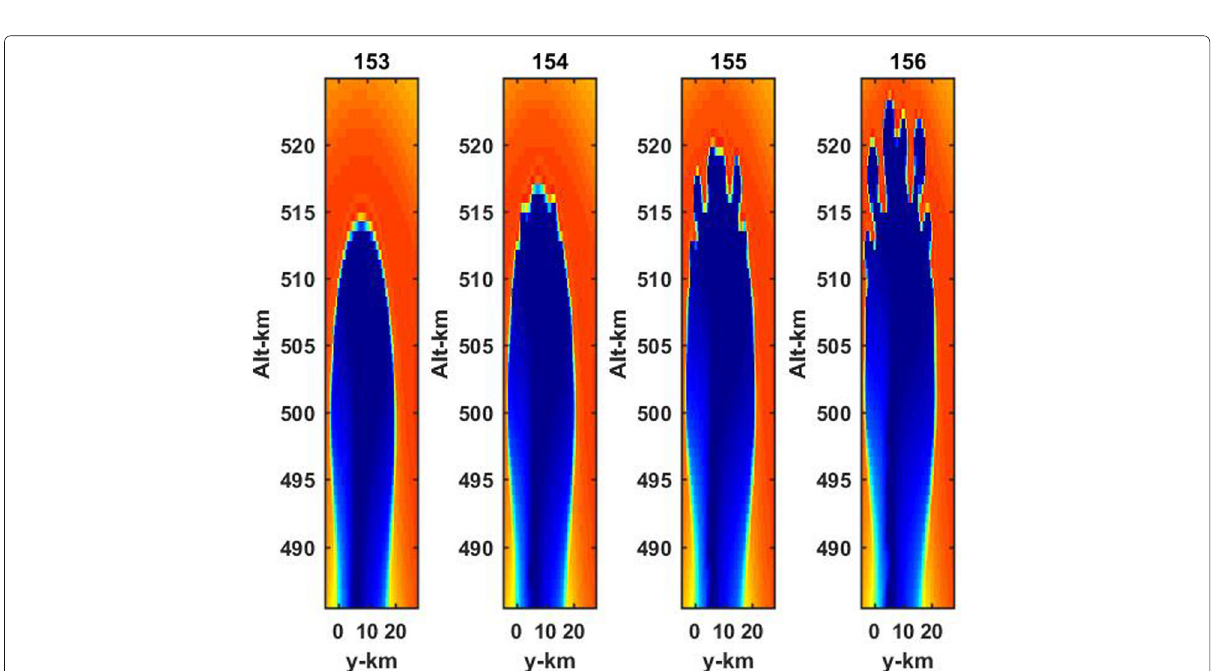
SDF. The following analytic representation is introduced